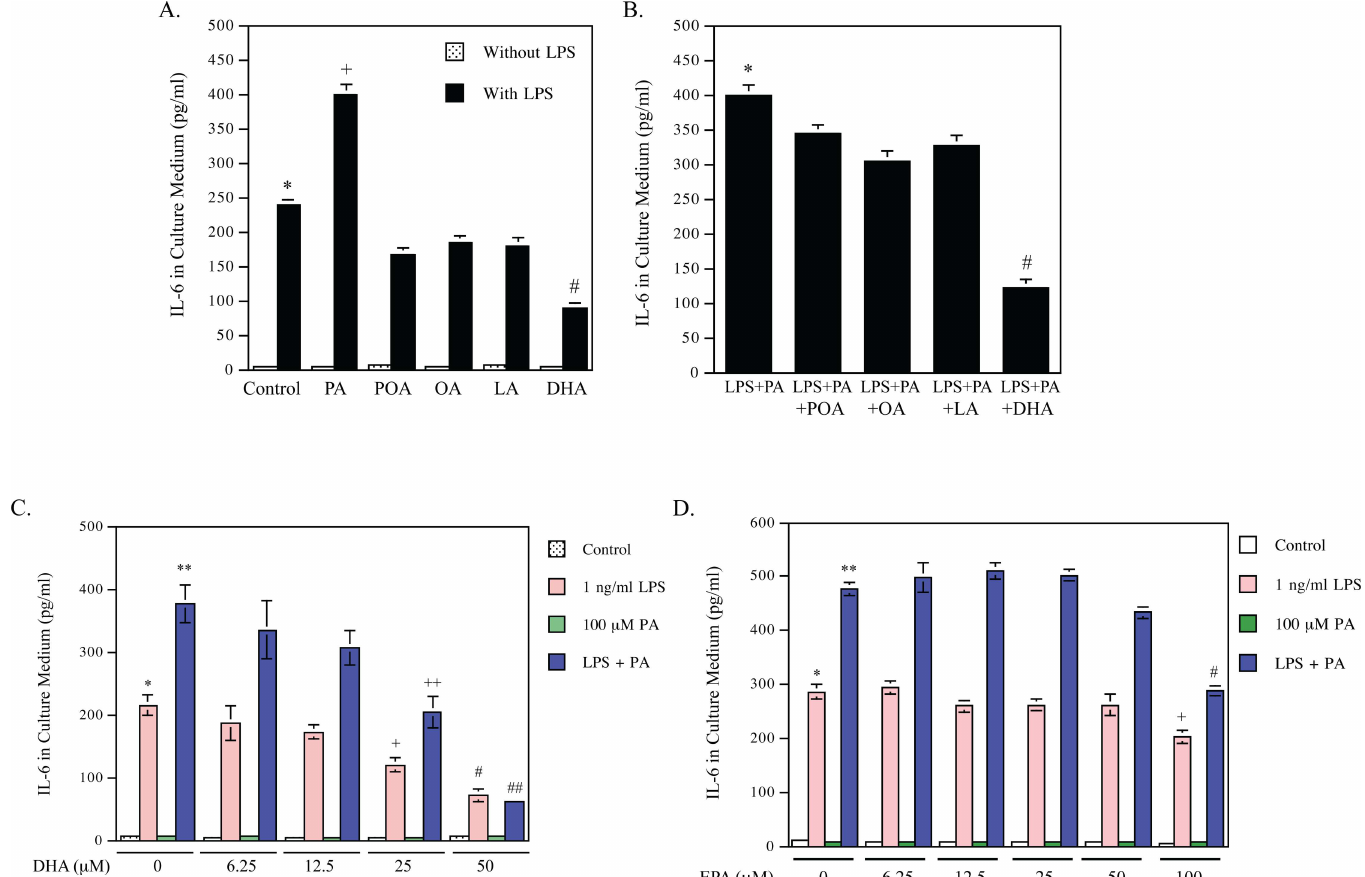
Fig 1. DHA inhibits IL-6 expression stimulated by LPS or LPS plus PA. A. RAW264.7 macrophages were treated with 100 μM of palmitic acid (PA), palmitoleic acid (POA), oleic acid (OA), linoleic acid (LA), or docosahexaenoic acid (DHA) in the absence or presence of 1 ng/ml of LPS for 24 h. After treatment, IL-6 in culture medium was quantified using ELISA. + vs. #, p < 0.01; # vs. (cid:3) , p < 0.01. B. RAW264.7 macrophages were treated with both 1 ng/ml LPS and 100 μM of PA in the absence or presence of 100 μ M of POA, OA, LA or DHA for 24 h. After treatment, IL-6 in culture medium was quantified using ELISA. # vs. (cid:3) , p < 0.01. C and D. RAW264.7 macrophages were treated with 1 ng/ml of LPS, 100 μM of PA or both 1 ng/ml LPS and 100 μM of PA in the absence or presence of different concentrations of DHA (C) or eicosapentaenoic acid (EPA) (D) for 24 h. After treatment, IL-6 in culture medium was quantified using ELISA. In panel C: (cid:3)(cid:3) vs. (cid:3) , p < 0.01; + vs. (cid:3) , p < 0.05; # vs. (cid:3) , p < 0.01; ++ vs. (cid:3)(cid:3) , p < 0.05; ## vs. (cid:3)(cid:3) , p < 0.01. In panel D: (cid:3)(cid:3) vs. (cid:3) , p < 0.01; + vs. (cid:3) , p < 0.05; # vs. (cid:3)(cid:3) , p < 0.01.